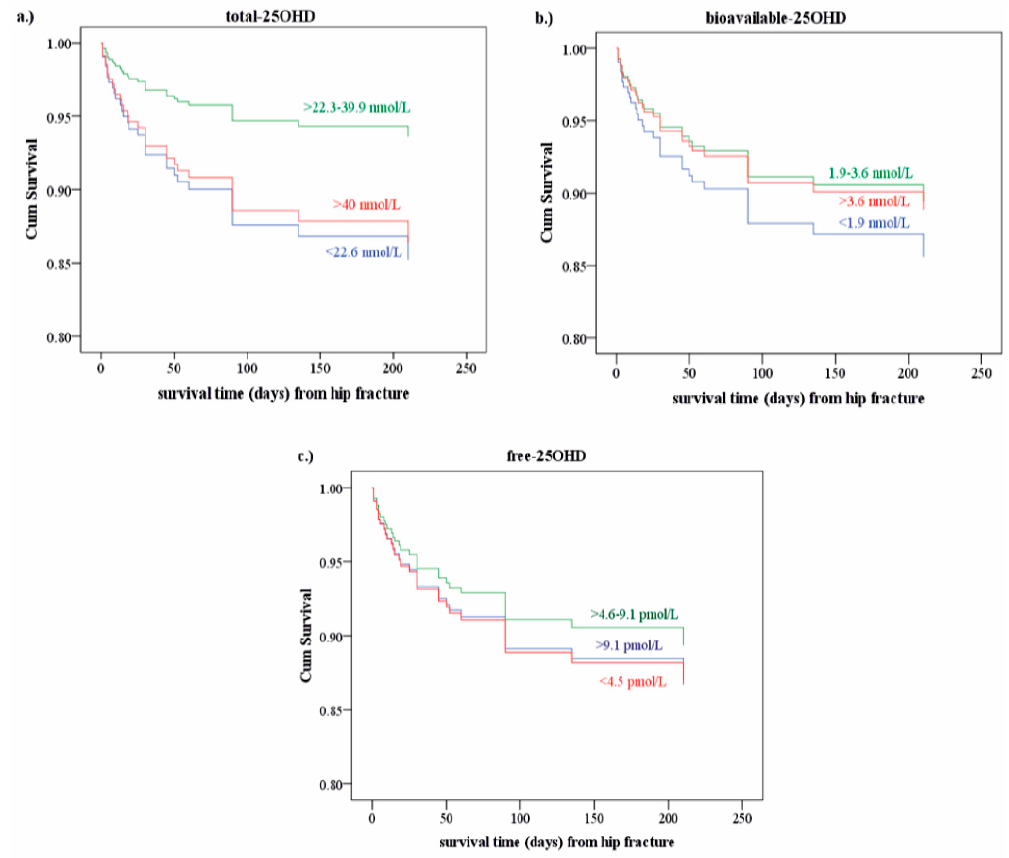
Figure 3. Ranges of circulating 25OHD forms and variability of cumulative survival times. ( a ) total-; ( b ) bioavailable-; ( c ) free-25OHD. The cumulative (cum) survival times depend on the 25OHD levels, especially of t-25OHD levels (trends without reaching statistical significance). The threshold values are given based on the values of our control group at 5th, 25th percentile.